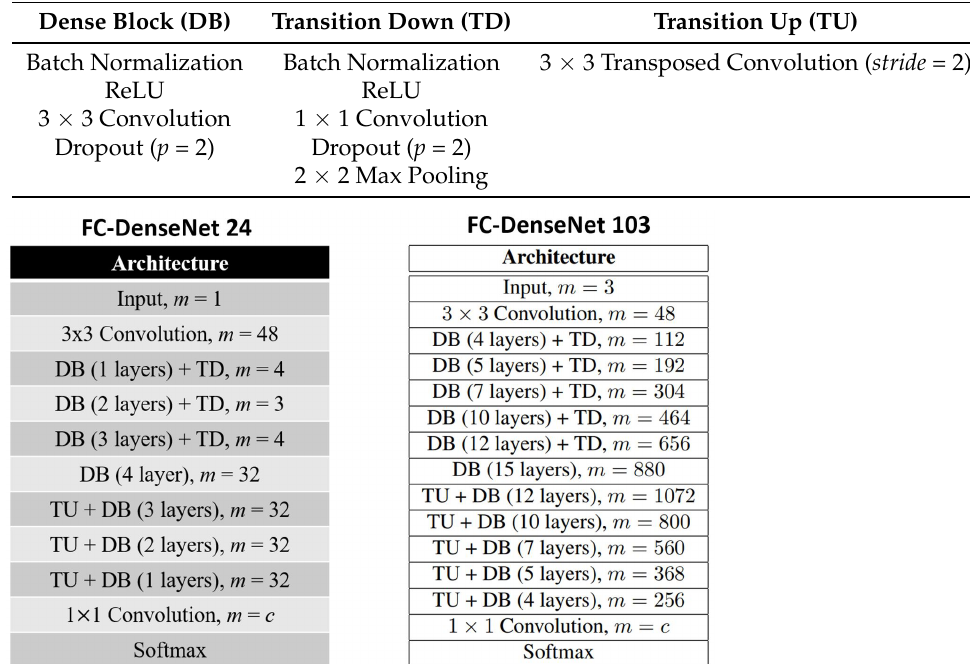
Table 2. The composition layers of the basic building blocks of FC-DenseNet24. From left to right: Dense Block (DB), Transition Down (TD), and Transition Up (TU).